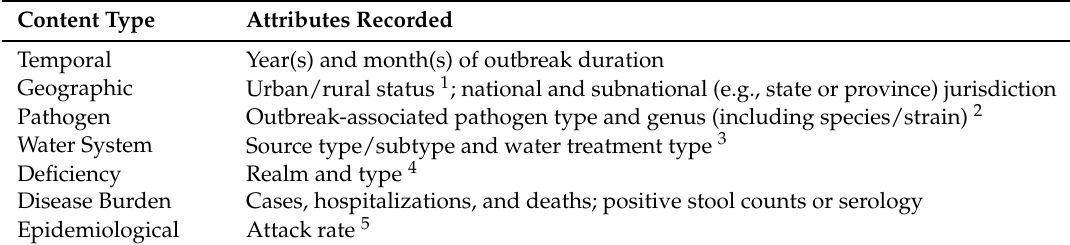
Table 1. Outbreak attributes recorded for drinking water disease